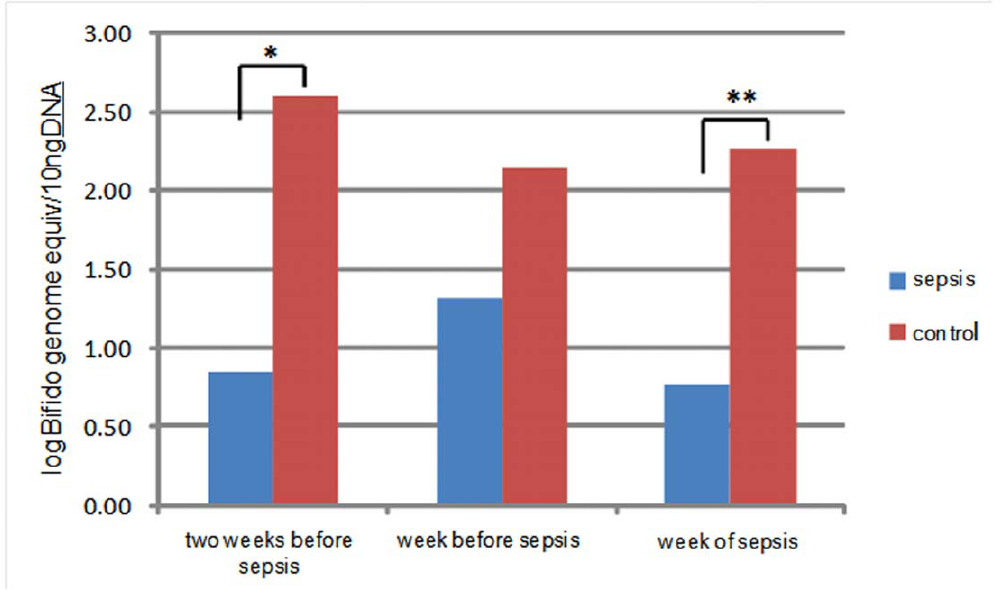
Figure 6. qPCR for fecal counts of Bifidobacteria. * p-value 2 weeks before LOS - 0.05; **p-value week of sepsis –0.03.